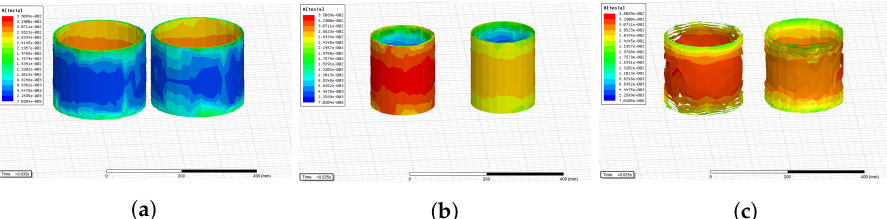
Figure 16. Cloud diagrams of the magnetic density distribution for the grid-side and valve-side windings under working condition 1. ( a ) Grid-side windings. ( b ) Valve-side windings.